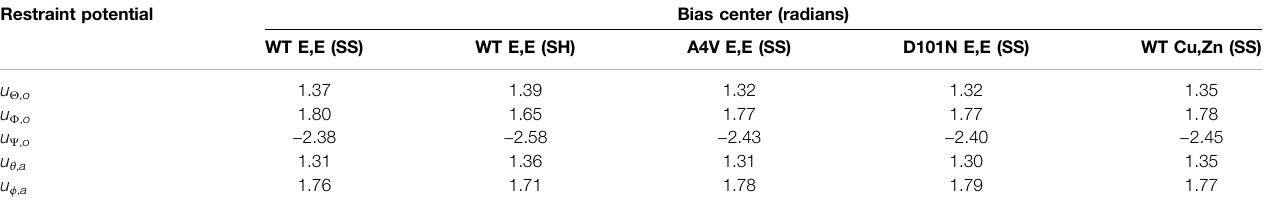
TABLE 5 | Central angle values for orientational and angular restraints. The spring constants for the restraints are all 1,000 kcal/mol/rad 2 . Restraint